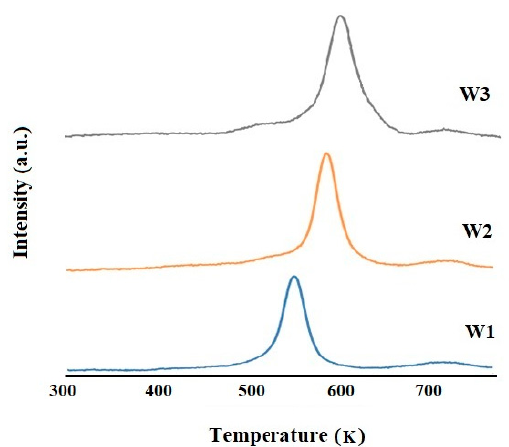
Figure 4. Temperature programmed reduction with hydrogen (H 2 -TPR) of powder the catalysts: W1, W2 and W3.